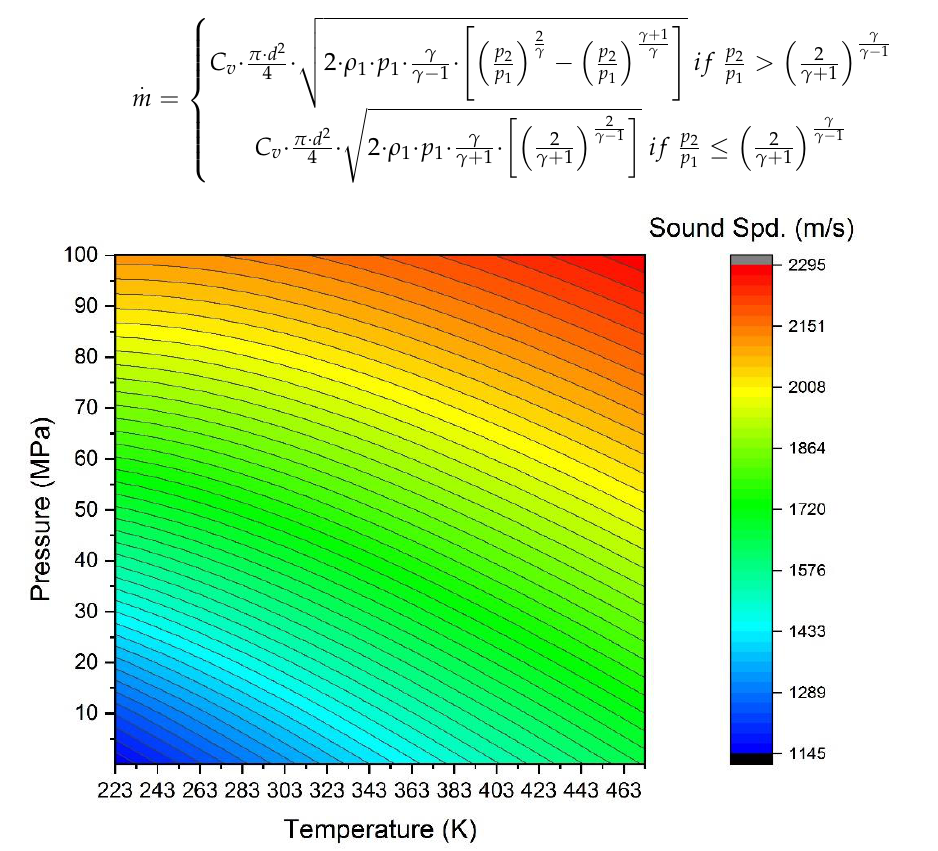
Figure 9. Hydrogen speed of sound as a function of pressure and temperature. Data processed from [40].